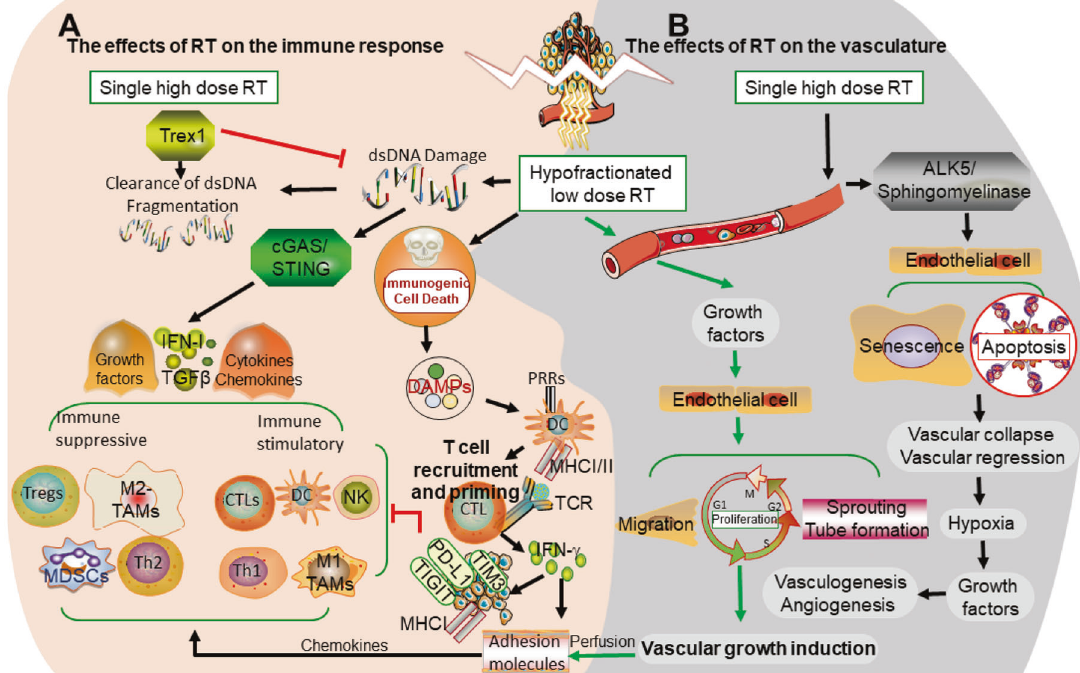
Fig. 2 Potential role of RT (fractionated low dose versus single high dose) on the tumor vasculature, tumor cell, and microenvironment. A Main effects of RT on the immune response. High-dose RT triggers TREX1 resulting in clearance of cytosolic dsDNA. Multiple chemokines, cytokines, and growth factors secreted, upon RT, via cytosolic dsDNA/cGAS/STING signaling, promote the recruitment of immune cells. RT facilitates an immune response by inducing immunogenic cancer cell death and DAMPs, which activate antigen-presenting cells such as DCs PRRs, and prime CTLs, ultimately causing the release of cytokines, which not only exerts an immunosuppressive role by potentiating PD-L1 level on tumor cells but also drives immune cell recruitment by upregulating leukocyte adhesion molecules in the vessel wall. B Main